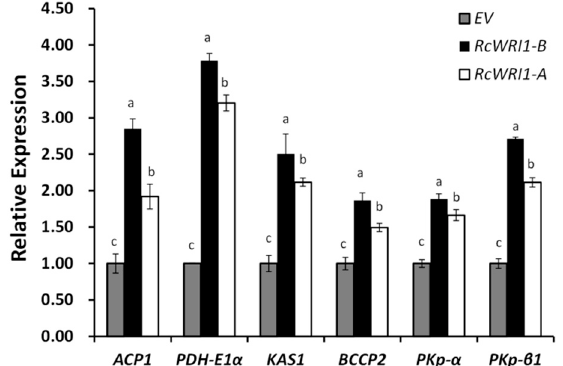
Figure 6. Expression profiles of WRI1 target genes in tobacco leaves expressing either RcWRI1-A or RcWRI1-B . Total RNA was isolated from the leaves expressing each of RcWRI1s , and used for qRT-PCR analysis. The primers were designed based on the coding sequences of PKp- β 1 , PKp- α , ACP1 , PDH-E1 α , BCCP2 , and KAS1 of N. benthamiana . EV indicates empty-vector control. NbActin was used as an internal control. Each value is the mean ± SD of six biological replicates. Letters a, b, c indicate a significant difference at the level of p < 0.05 according to the Tukey’s test.